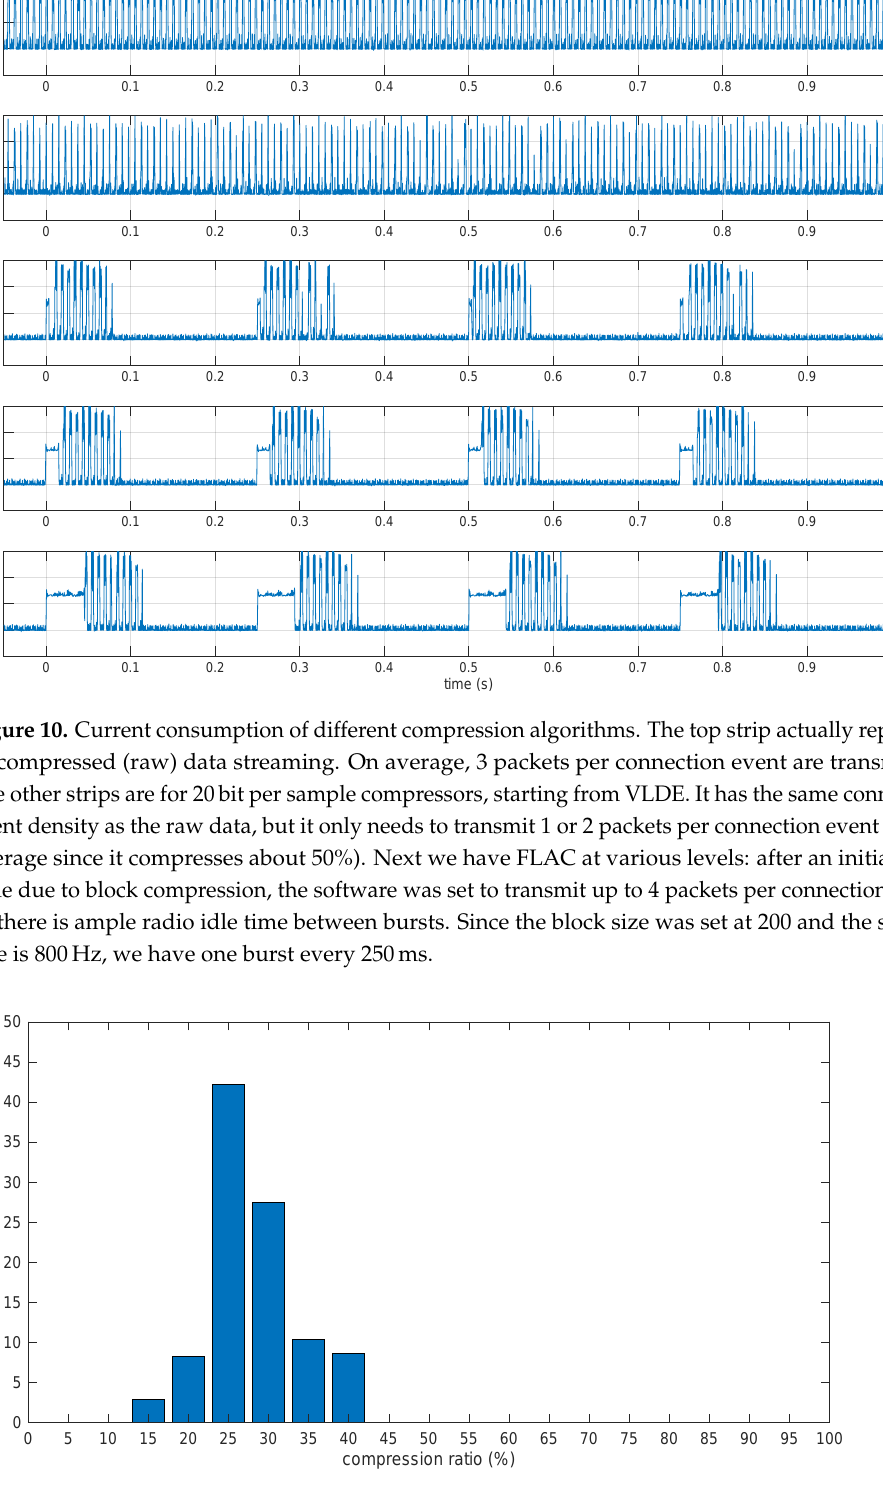
Figure 11. Histogram of the compression ratios achieved by FLAC level 0 over the whole available signal. 20bits per sample setting, 200 sample block